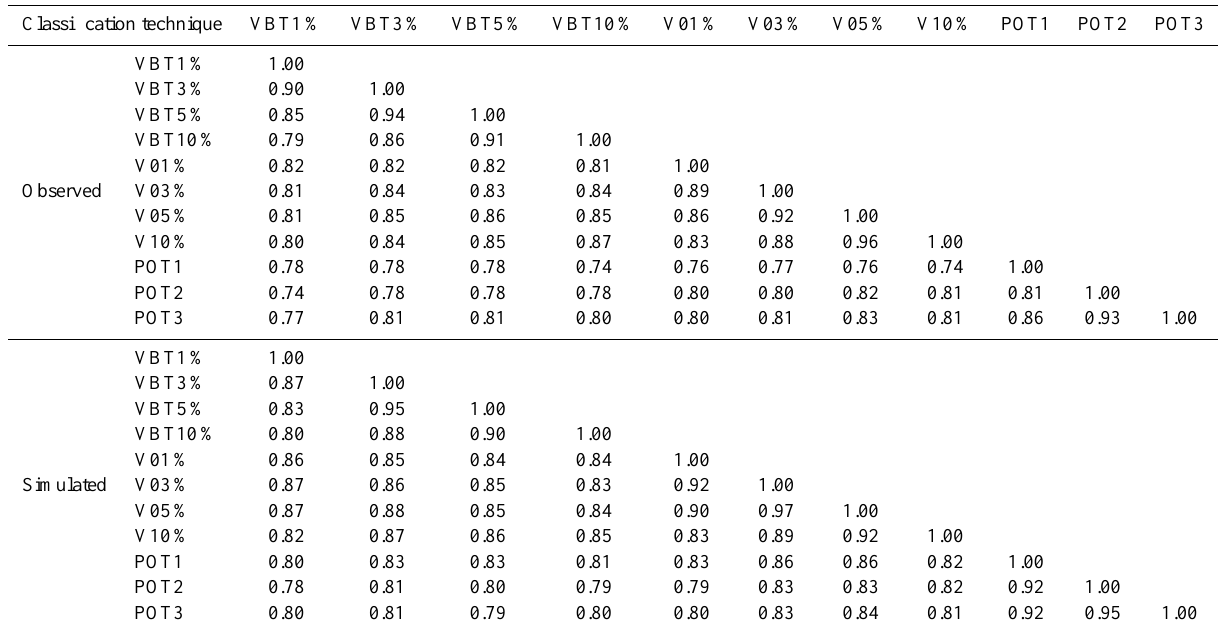
Table 1. Cross-correlations of peak month (PM) at locations where the PMs differ by at least one classification technique (this occurs at 61% of stations and 54% of associated grids).